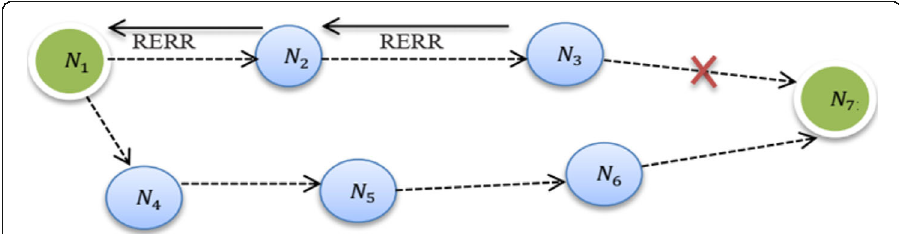
Fig. 2 Route maintenance using RERR packets. When the link between node N 3 and destination node N 7 is disconnected, then the intermediate node N 3 sends a RERR message to the source node N